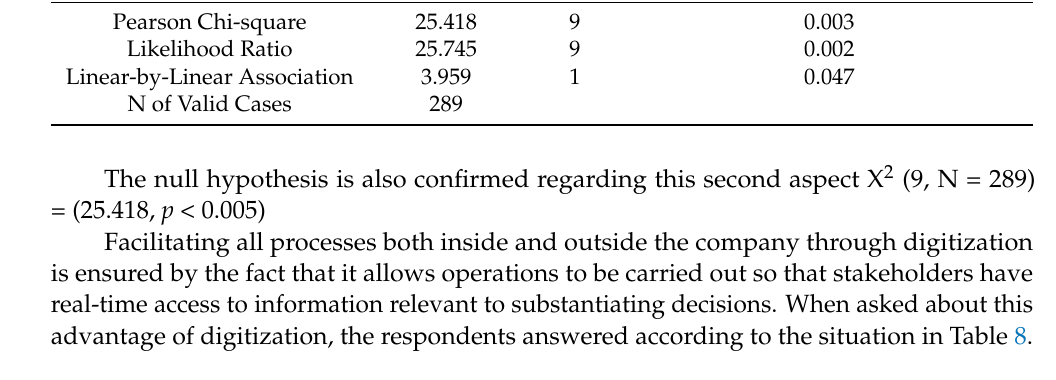
Table 8. Correlation between respondents’ experience and appreciation of the extent to which digitization facilitates real-time access to